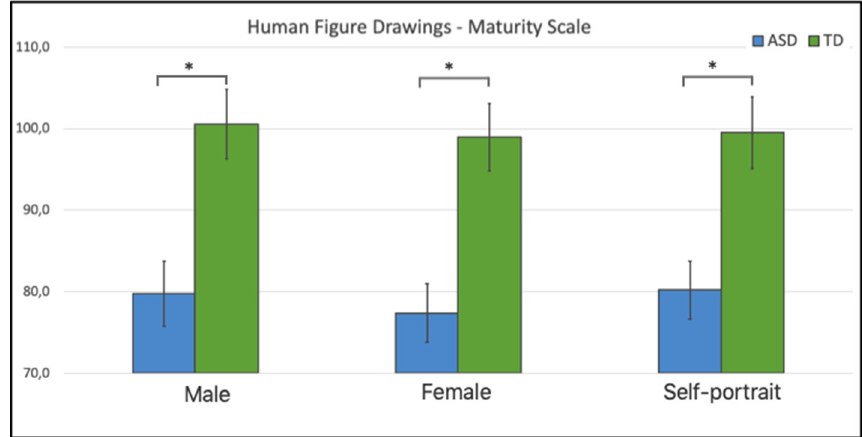
Figure 2. Maturity scale in the three drawings across ASDs and TD children. Bars indicate standard errors; asterisks a p -value < 0.01.